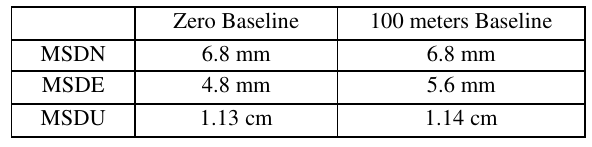
Table 2. Mean standard deviations for Two Baselines